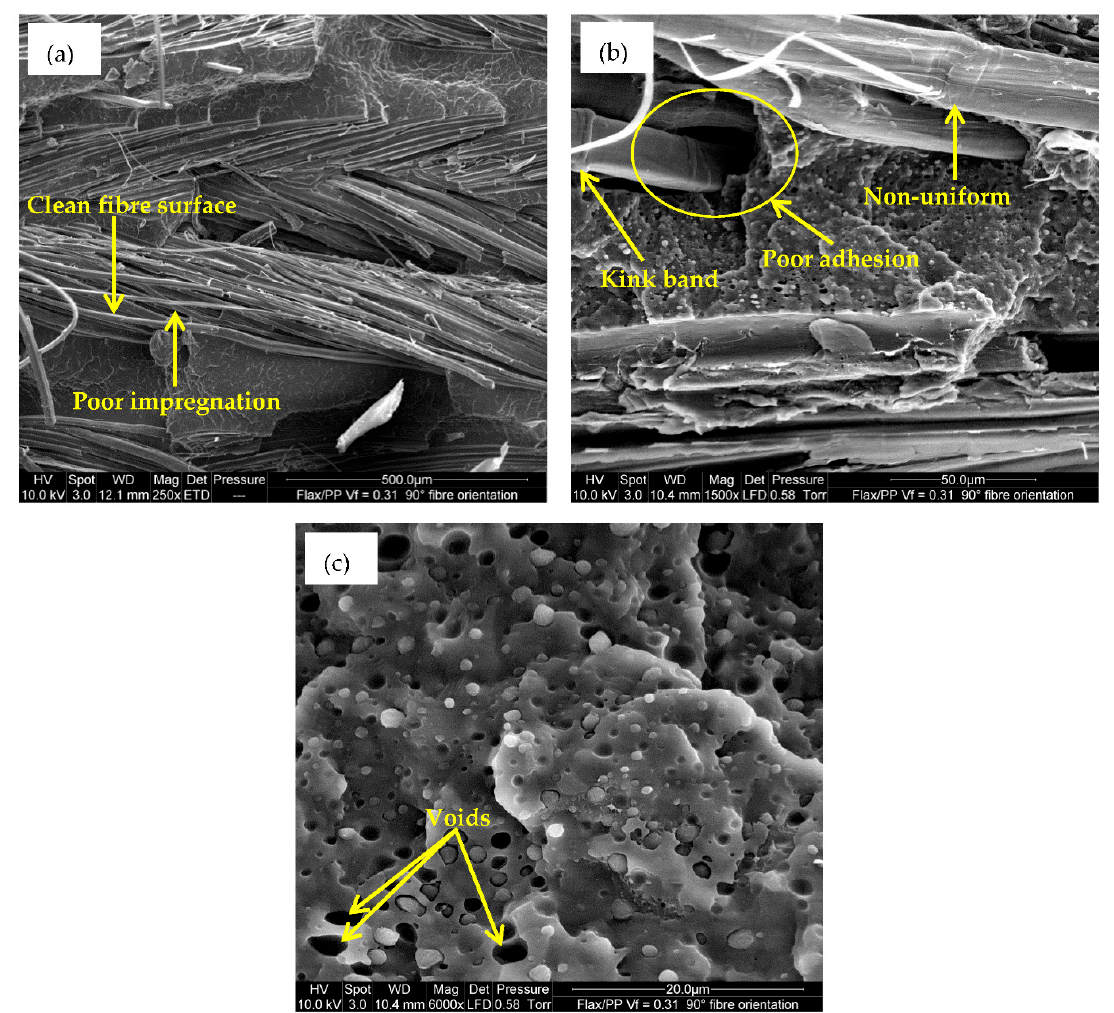
Figure 14. ( a ) Poor impregnation of yarn by the matrix, ( b ) poor adhesion between flax fibres and PP, and ( c ) voids in a matrix-rich region. and ( c ) voids in a matrix-rich